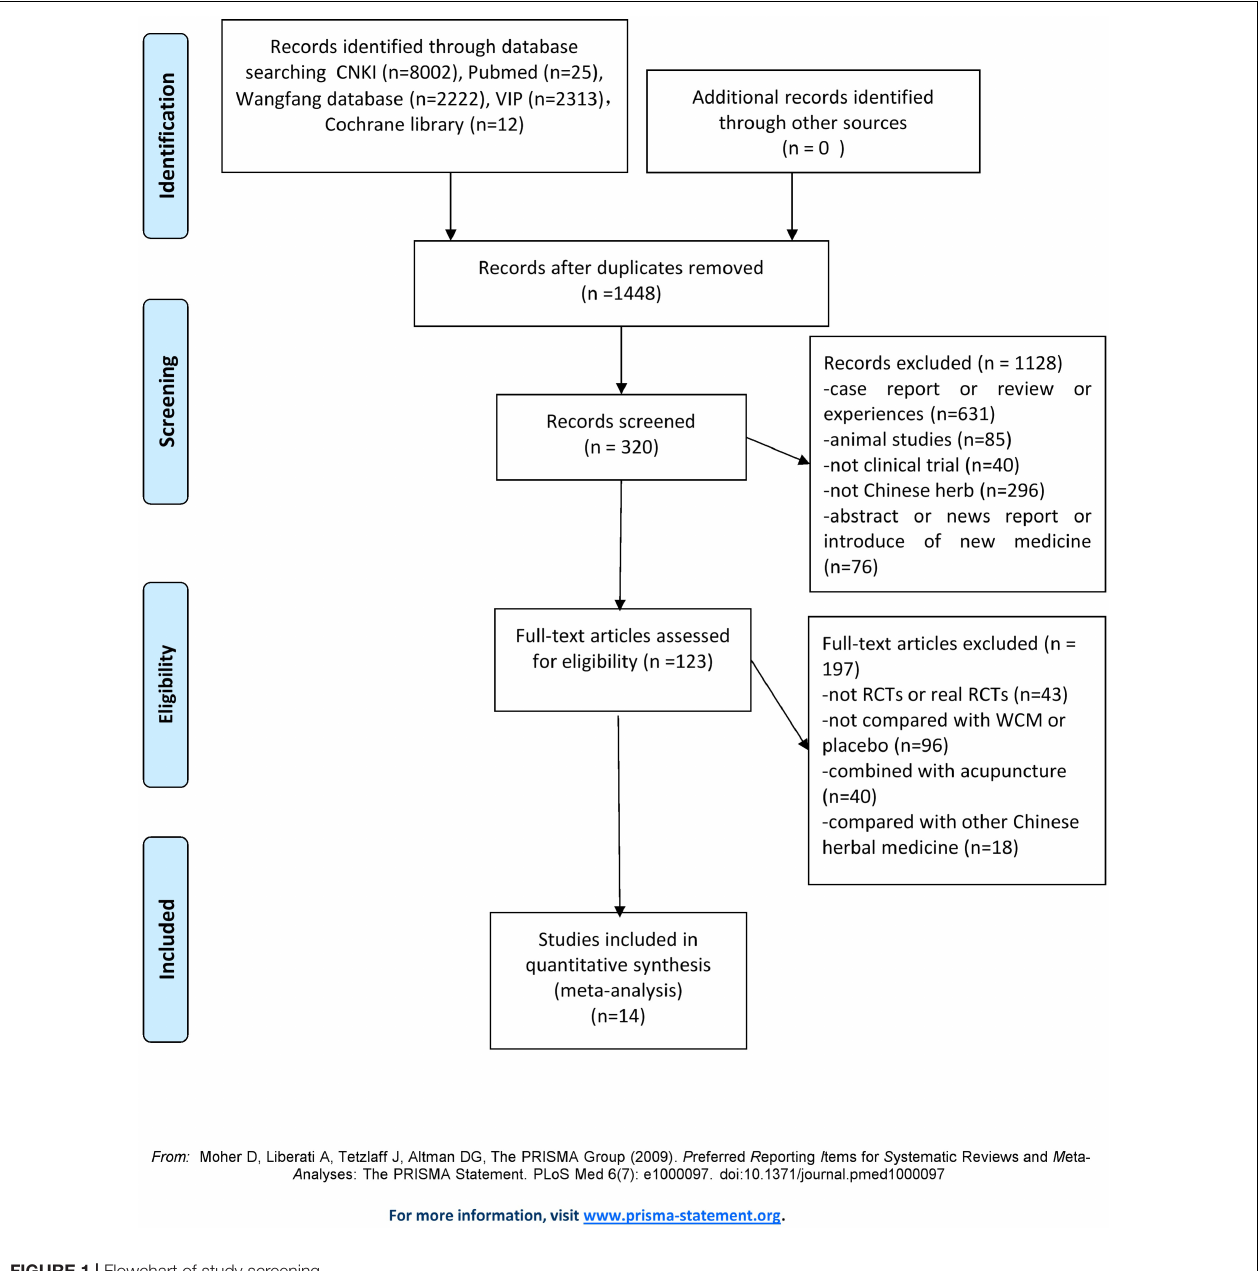
FIGURE 1 | Flowchart of study